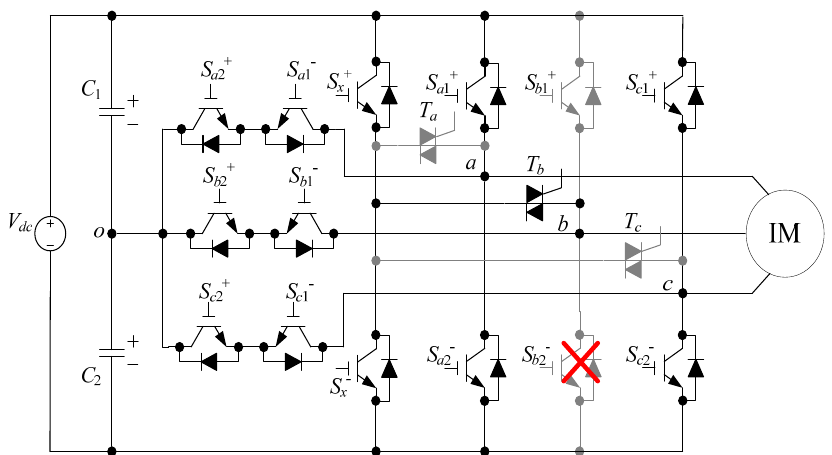
Figure 11. Tolerant control state when an open-circuit fault occurs in inverter switch S b 2 − .